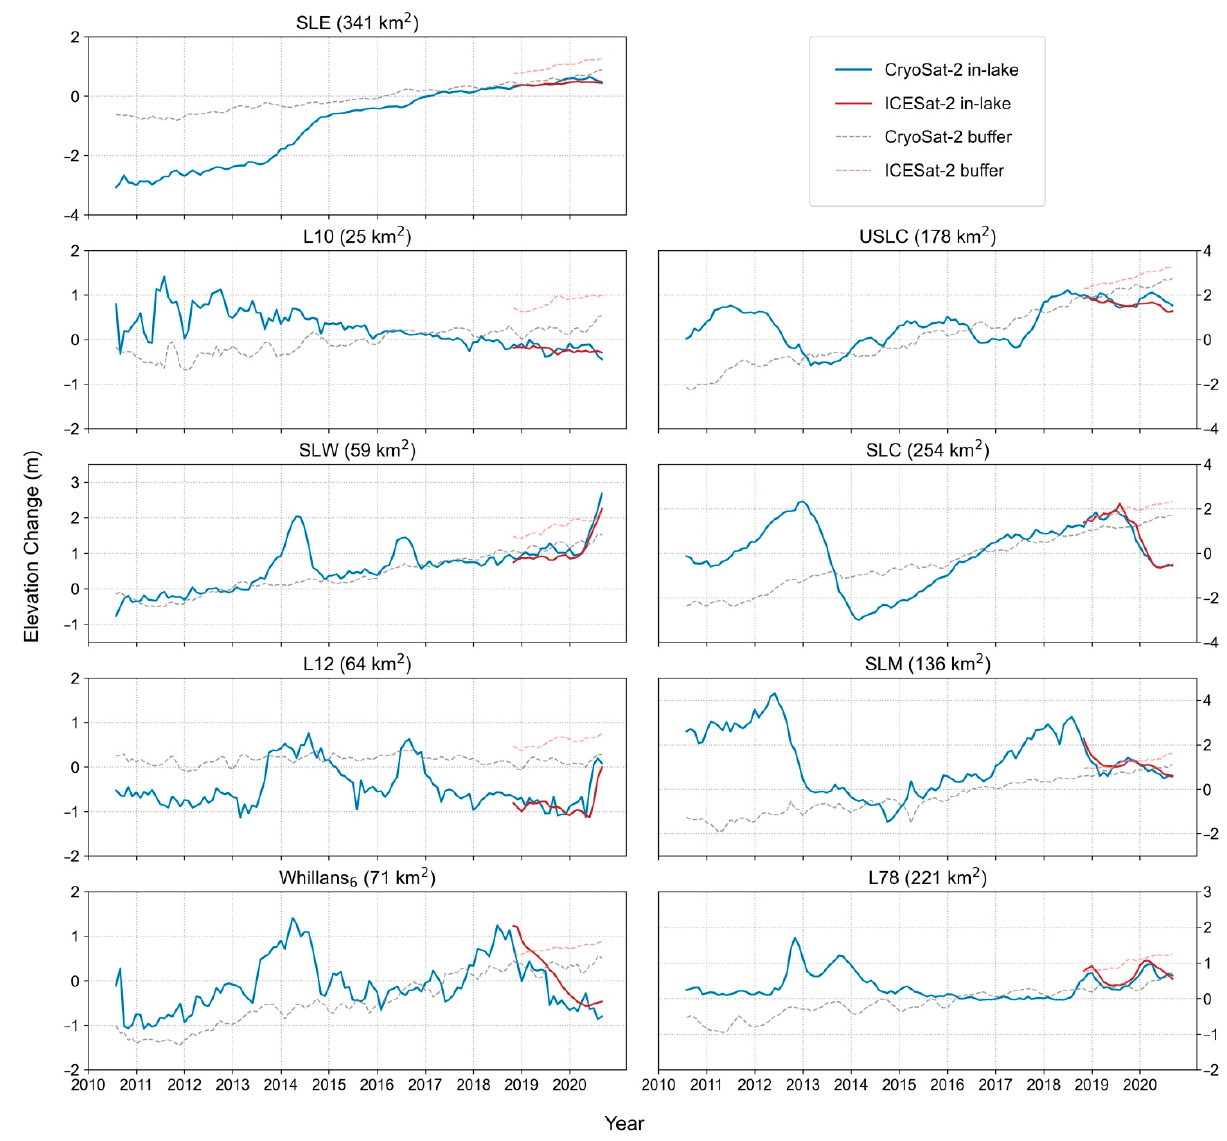
Figure 3. Time series of the ice surface elevation changes of the subglacial lakes beneath the Mercer and Whillans Ice Streams. The regional elevation changes are also shown in dotted lines. The subplots are mainly arranged from upstream to downstream. However, the order of the subplots for SLE, L10, SLW, and L12 have been adjusted for analysis.